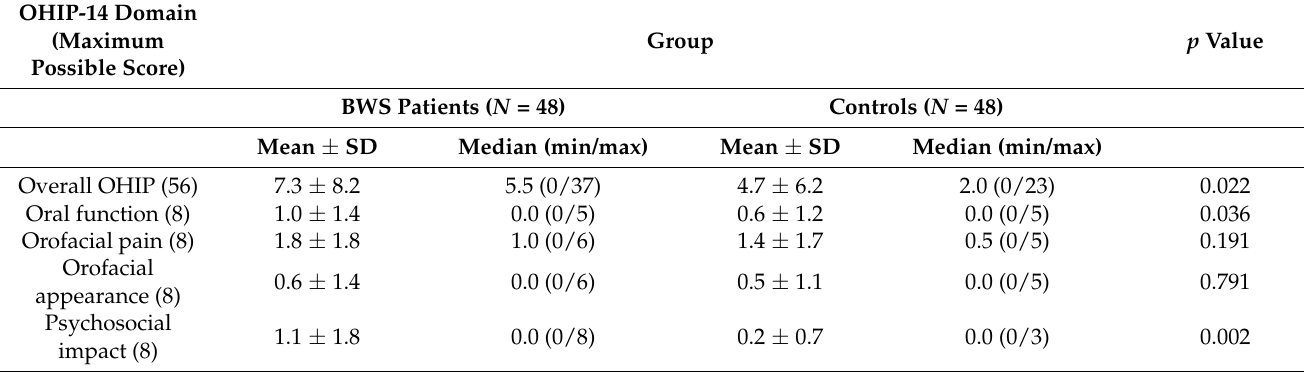
Table 1. Overall and subscale OHIP-14 scores by group.